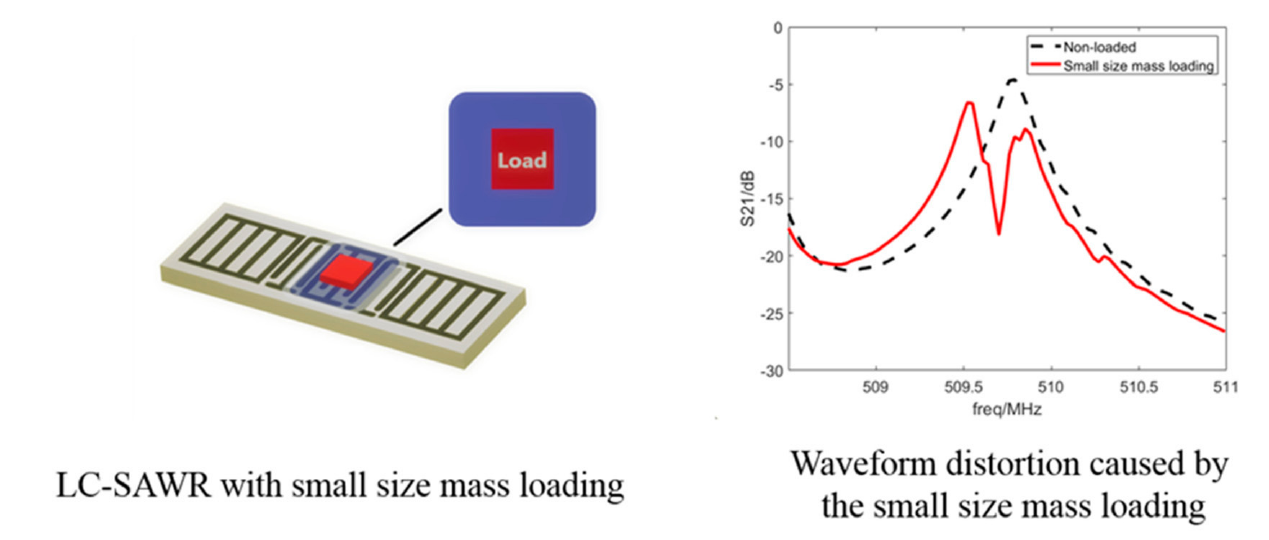
Figure 1. LC-SAWR with small size mass loading ( left ) and the waveform distortion ( right ).